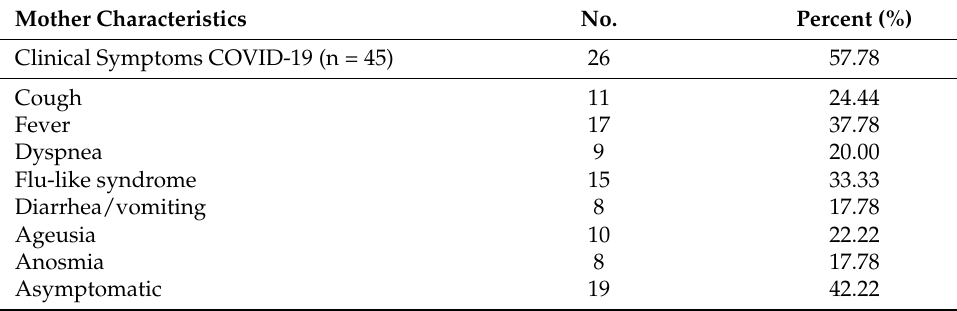
Table 2. Clinical symptoms of pregnant women diagnosed with COVID-19.